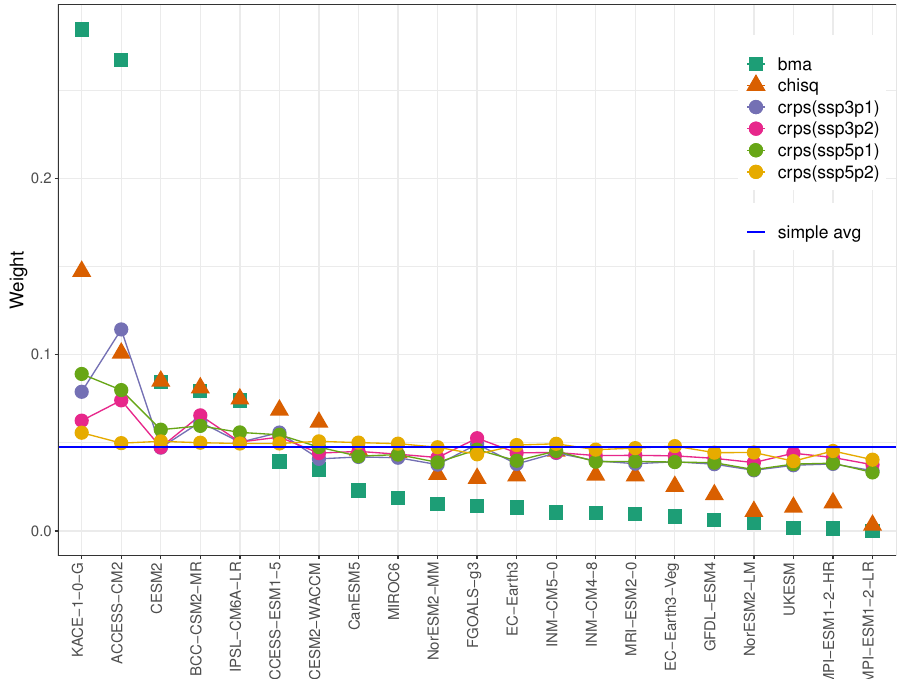
Figure 6. Spread of the weights for 21 models obtained from various α -weighting methods based on the Bayesian model averaging (bma), chi-square statistic (chisq), and the continuous rank probability score ( crps ) for the future periods P1 (2021–2060) and P2 (2061–2100) under the SSP3 and the SSP5 scenarios. The weights calculated at each grid cell are averaged over 15 grid